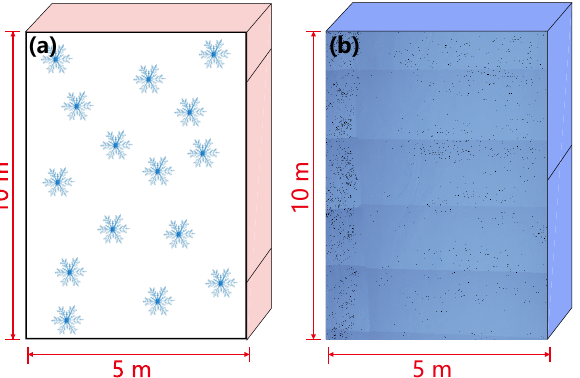
Figure 9. The selection of test area consists of two parts: ( a ) a schematic diagram of the sampling area; and ( b ) a real-time point cloud of the sampling area.